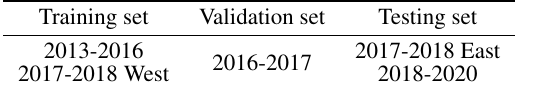
Table 3. Split of the dataset into training, validation and testing sets. For each pair of PCs, years relates to the year of acquisition given in Table 1. The annotation is always given for the second PC of the pair with regards to the first